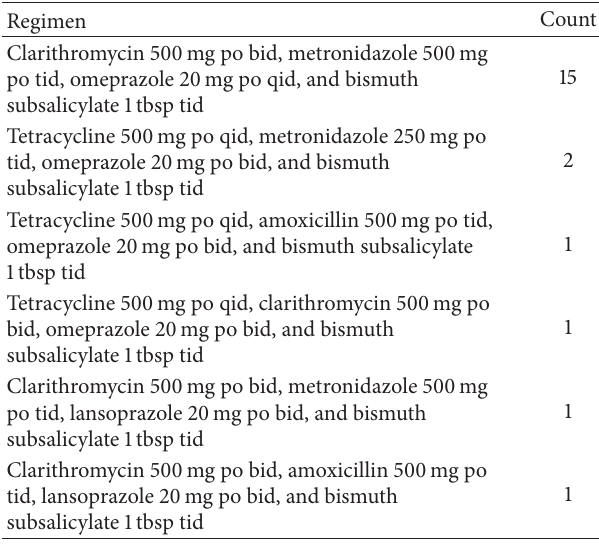
Table 3: Treatment regimen for H. Pylori